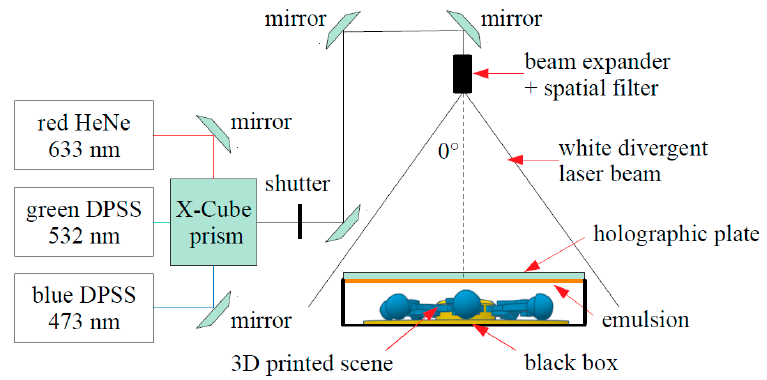
Figure 1. Zero-degree single-beam reflection Denisyuk hologram setup.